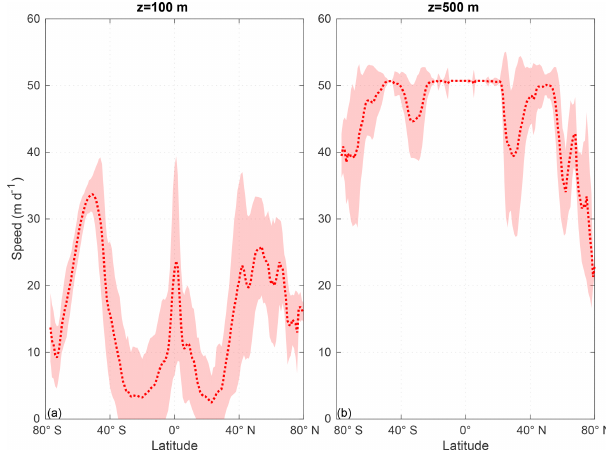
Figure 7. Zonal mean sinking speed of detritus (md − 1 ; dotted line) and its standard deviation (shaded) of ECCO1.0 ∗ for a depth of 100m (a) and for a depth of 500m (b)